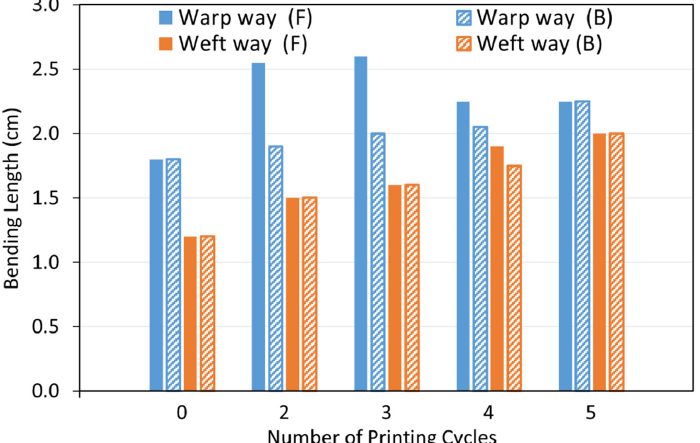
Figure 9. Bending lengths of the face (F) and back (B) side of the metallised textiles printed with the Cu–Ag NP catalyst at different numbers of cycles and directions.